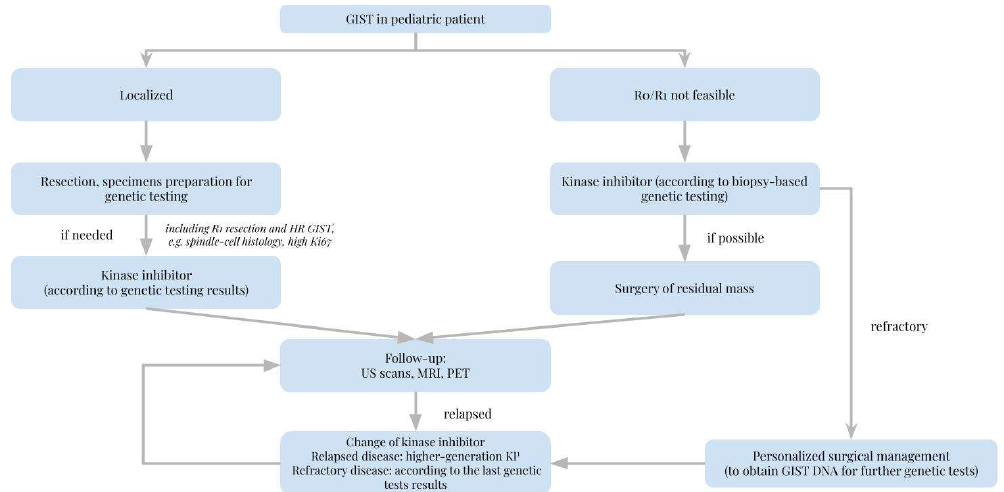
Figure 2. Management algorithm when a gastrointestinal stromal tumor in a pediatric patient is diagnosed.